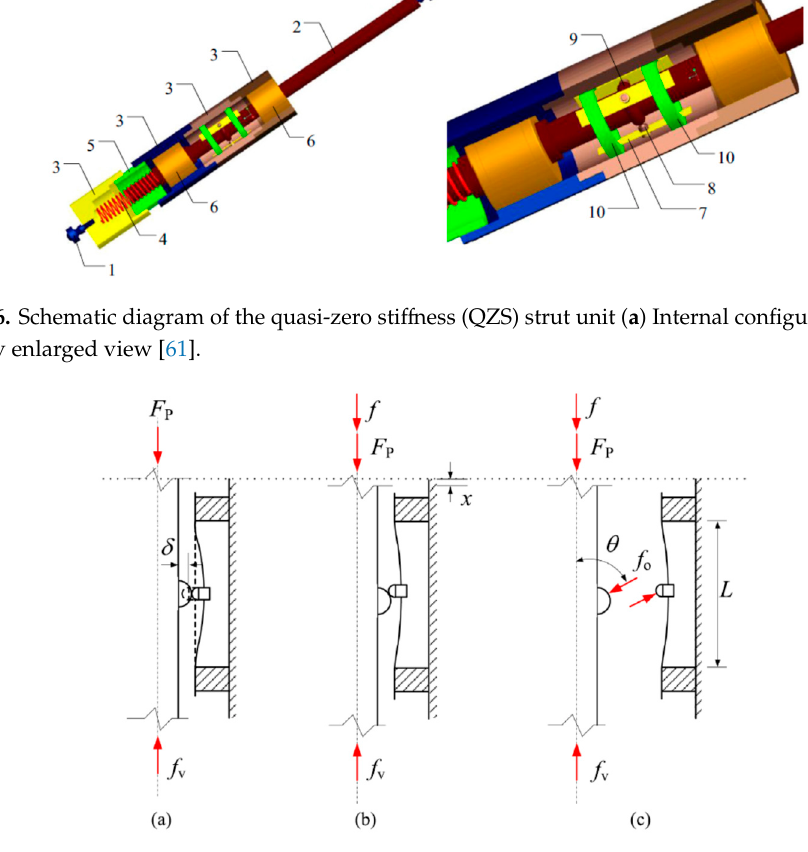
Figure 8. Schematic diagram of the QZS torsional vibration isolator. ( a ) Longitudinal-sectional view of the assembly, ( b ) cross-sectional view. Labels: 1-cam with radius r 2 , 2-roller with radius r 1 , 3-spring, 4-slider, 5-vulcanized rubber cam, 5-cylinder roller, 6-left shaft connector, 7-right shaft connector [58]. Guangxu [62] has presented a multi-direction vibration isolator of the high-static–low-dynamic stiffness (HSLDS) struts, the schematic diagram of which is shown in Figure 9. Figure 9a shows the static equilibrium position; Figure 9b shows the base excitations x0(t), y0(t), and z0(t) applied to the isolator; Figure 9c shows the equivalent mechanical model of the isolator. The proposed multi- direction vibration isolator can possess the HSLDS characteristics in the vertical direction and quasi- zero stiffness in two horizontal directions. Besides, the low-frequency isolation bandwidth can also